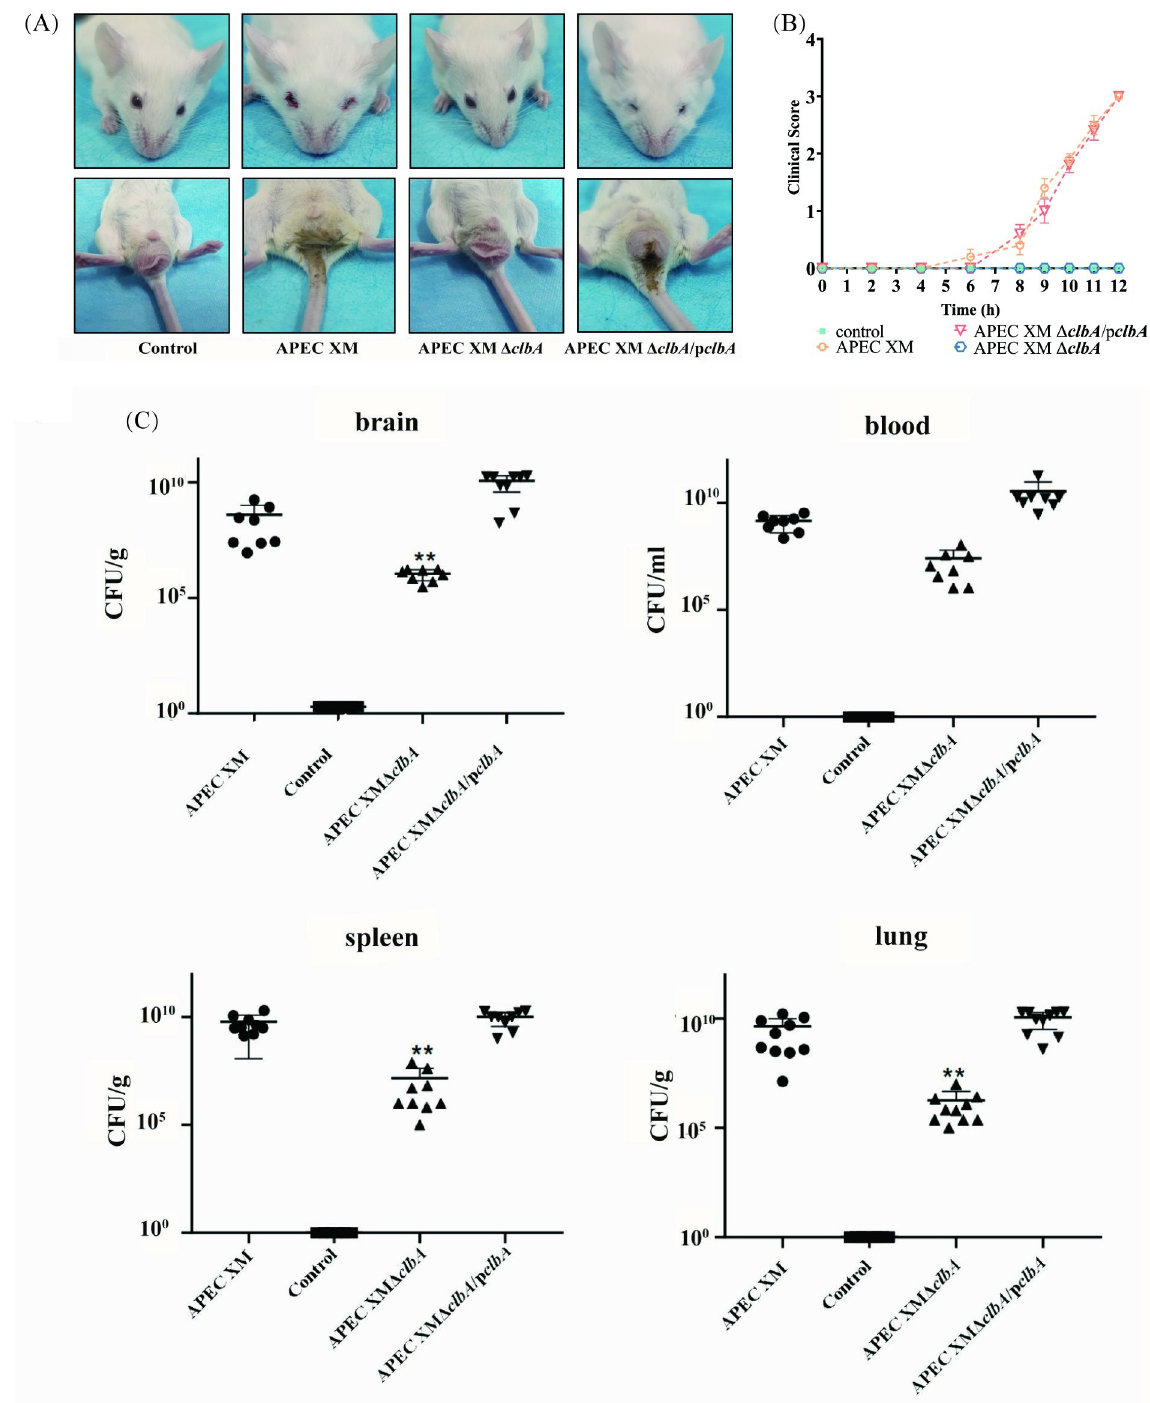
Fig 1. ClbA is required for the virulence of APEC XM in vivo . (A) Clinical symptoms of mice after 12h infection. The mice infected by APEC XM suffered from lethargy, thick eye discharge and diarrhea. The mice infected by APEC XM Δ clbA displayed very mild symptoms. (B) Clinical scores of mice which challenged with APEC XM, APEC XM Δ clbA and APEC XM Δ clbA /p clbA for 12h infection. Ten mice in each group were used this experiment. The clinical scores were recorded at time points of 2, 4, 6, 8, 9, 10, 11, 12 hour. Data were analyzed with one-way ANOVA and presented as the mean ± standard errors of the mean for the clinical scores of 10 mice in each group. (C) Bacterial loads in the brain, blood, spleen and lungs of infected mice after 12 h of infection. 10 mice in each group were used in this experiment. Dots represent the values of bacterial loads in the organs of each infected mouse which are calculated by plate counting with triplicate replicates. Data were analyzed with